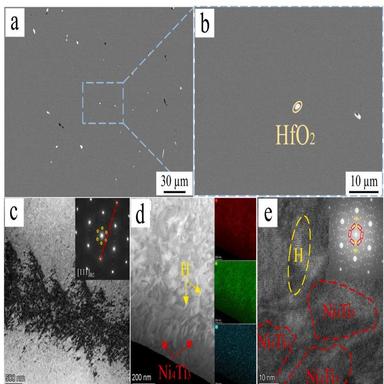
Microscopic morphology of Ni55Ti37Hf8 alloy after aging treatment, (a)-(b) SEM morphology, (c) Low-magnification TEM morphology, (d) HADDF morphology with corresponding elemental mapping of Ni (red), Ti (green), and Hf (blue), (e) High-resolution morphology of matrix.